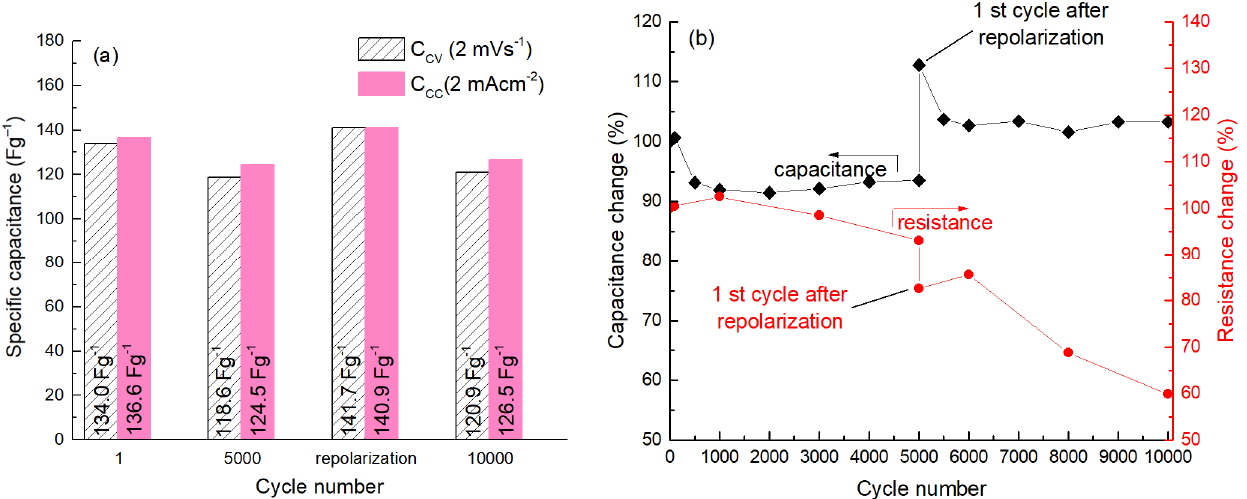
Figure 3. The specific capacitance by CC and CV ( a ), and retention in capacitance and resistance ( b ) ( b ) of 2-electrode cell at 1.5 of 2-electrode cell at 1.5 V.